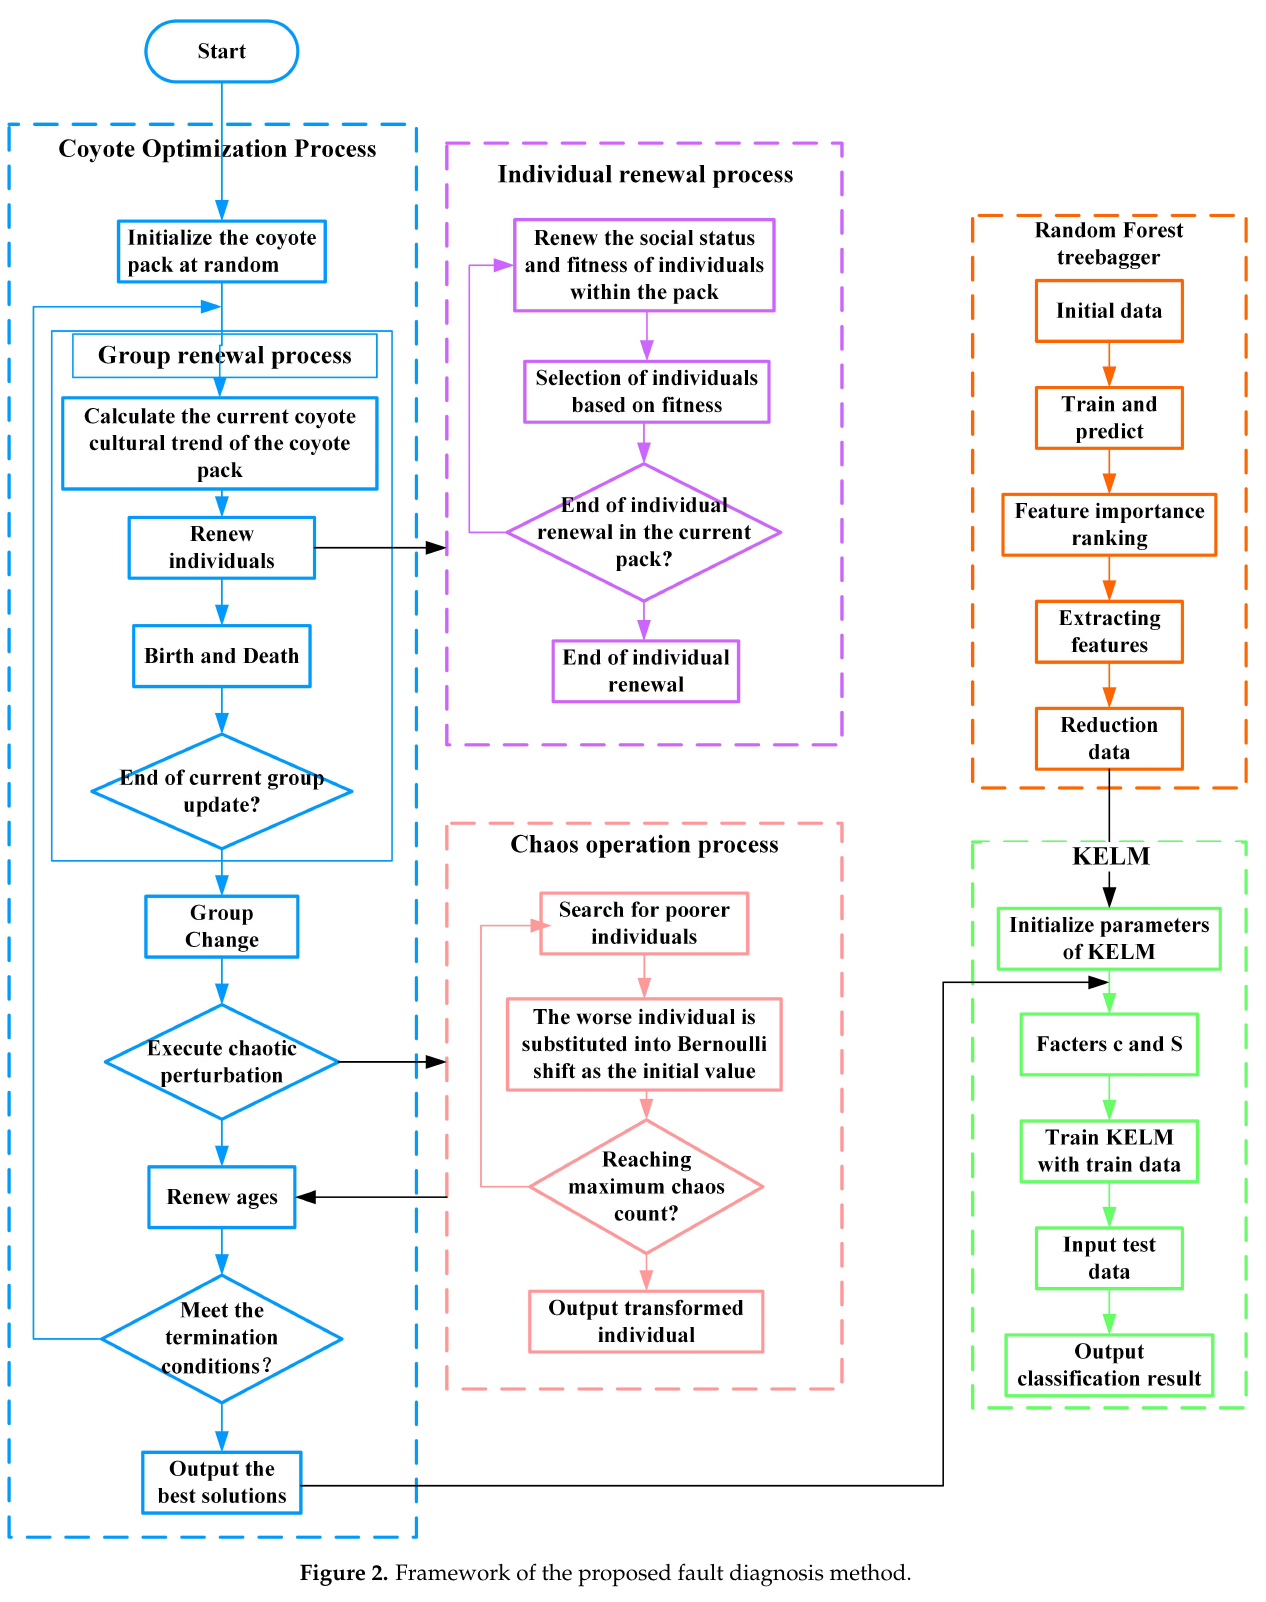
Figure 2. Framework of the proposed fault diagnosis